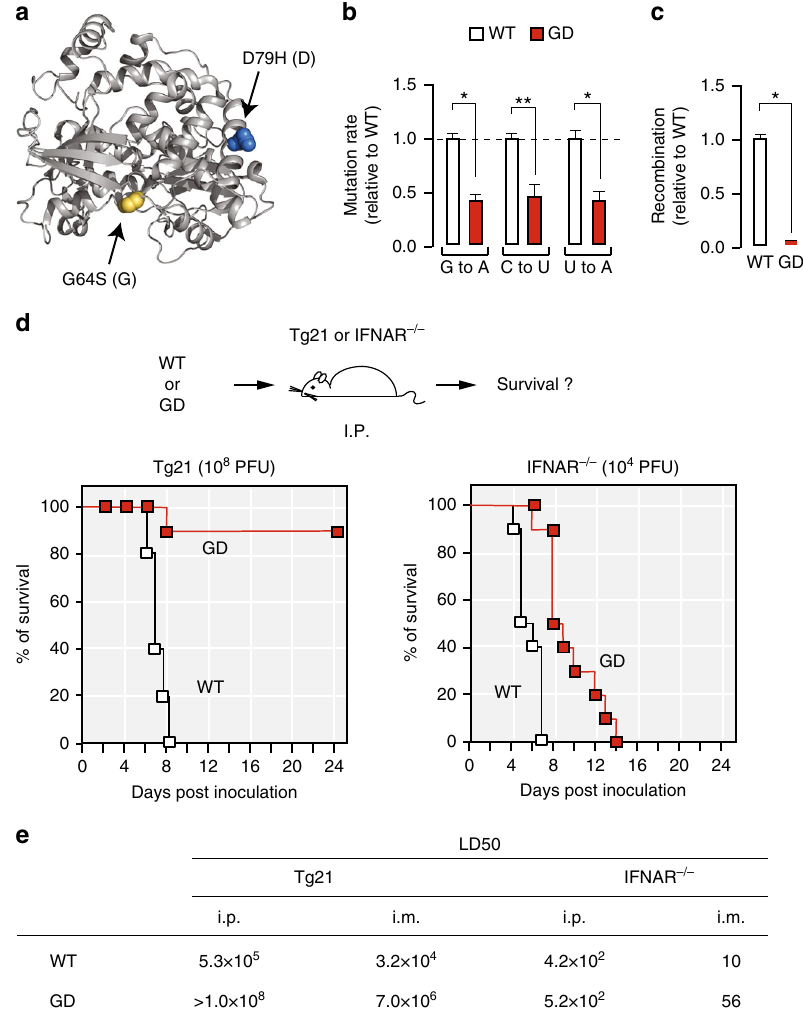
Fig. 1 RNA viral evolution capacity is required to overcome the type I interferon (IFN) response. a The structure of RNA dependent RNA polymerase (RdRp) of poliovirus. G64S (G) confers higher replication fi delity and D79H (D) reduces recombination rate 24 – 26 . b Mutation rates associated of wild type (WT) and G64S/D79H (GD) poliovirus. Mutation rates are shown for G to A, C to U and U to A substitutions, based upon the frequency of lethal mutations ( P < 0.05, seven passages, n = 7, mean ± s.d.). c Recombination rates for WT and GD poliovirus. For additional details see Supplementary Fig. 1. d Percentage survival of Tg21 mice or IFNAR − / − mice ( n = 10 for each cohort) infected with virus by I.P. inoculation route. Mice were inoculated with 10 8 plaque-forming units (PFU) per Tg21 mouse or with 10 4 PFU per IFNAR − / − mouse ( n = 10 for each cohort). e 50% lethal dose (LD50) by intra-peritoneal (I.P.) and intra-muscular (I.M.) route ( n = 10 for each